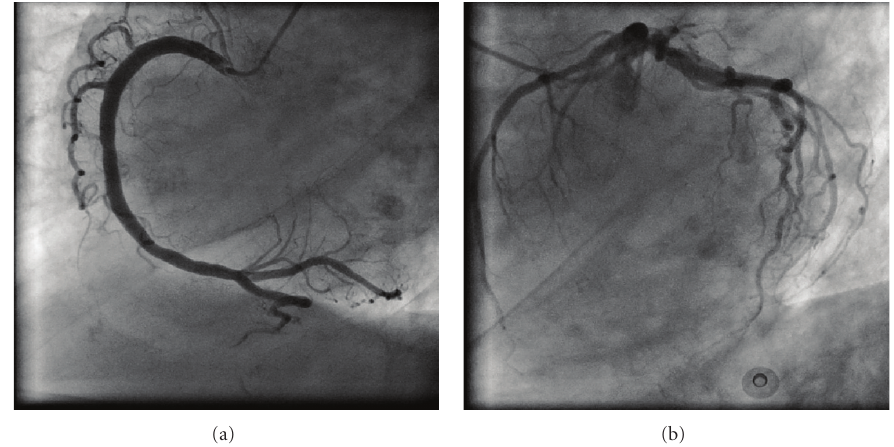
Figure 2: Coronary angiogram minor disease in the left anterior descending artery but no other coronary artery disease.